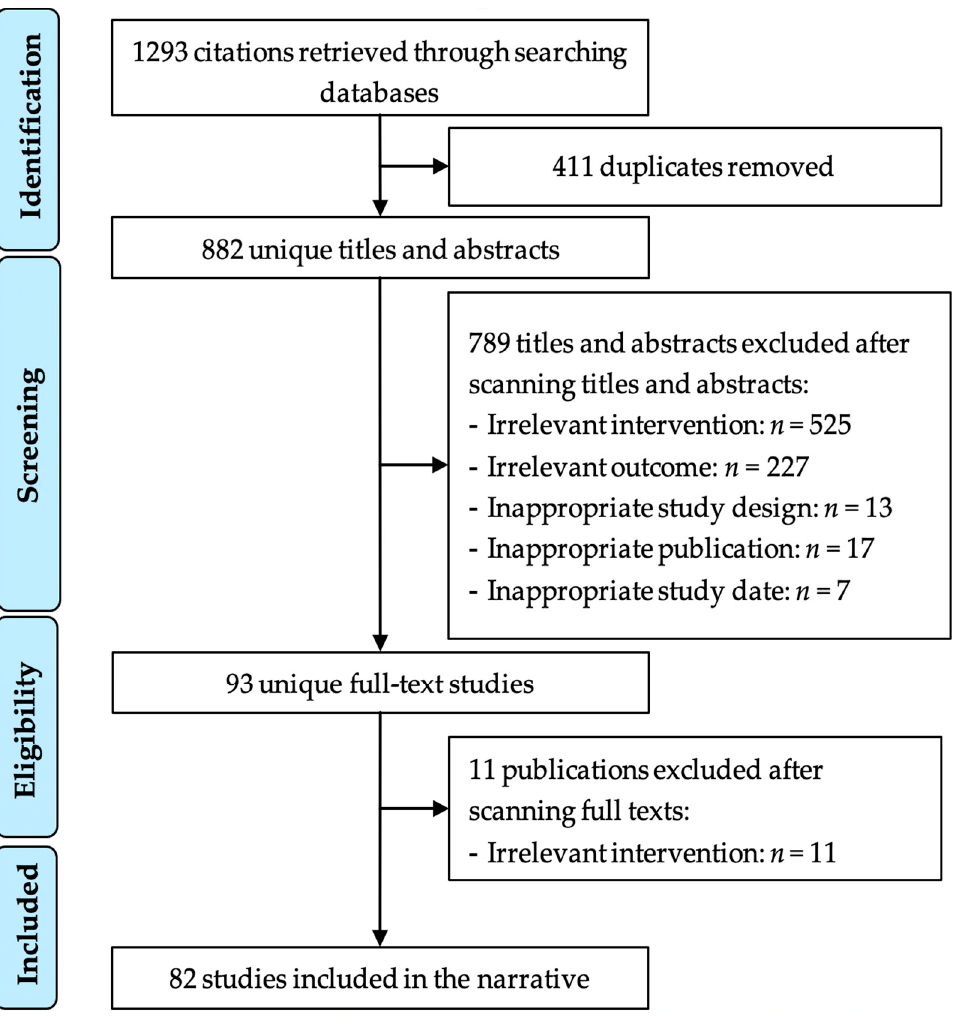
Figure 1. Study selection process.